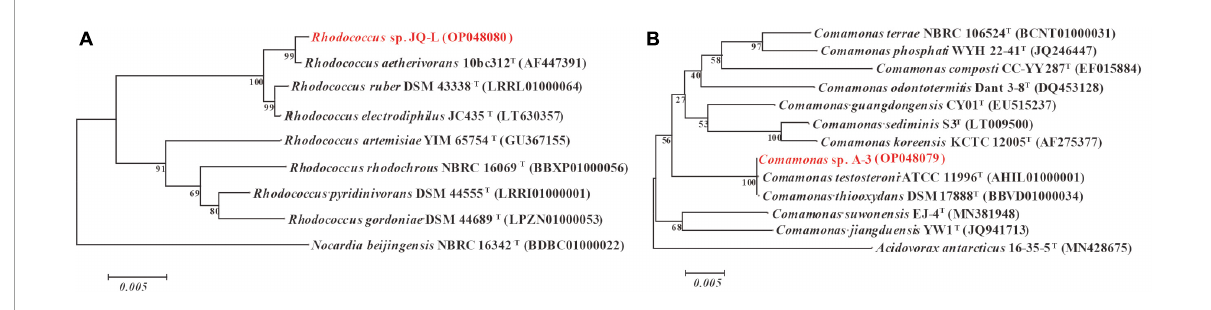
FIGURE1 Phylogenetic analysis of strains JQ-L (A) and A-3 (B) with closely related type strains by neighbor-joining method based on 16S rRNA gene sequences. Bootstrap values (%) are indicated at the nodes, the scale bar represents 0.005 substitutions per site. The GenBank database accession numbers were shown in parentheses.